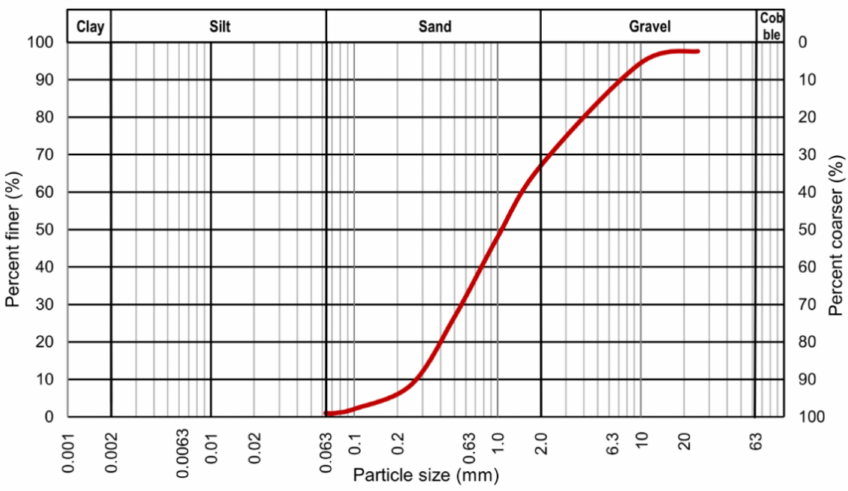
Figure 2. Grain size distribution curve of the tested granular